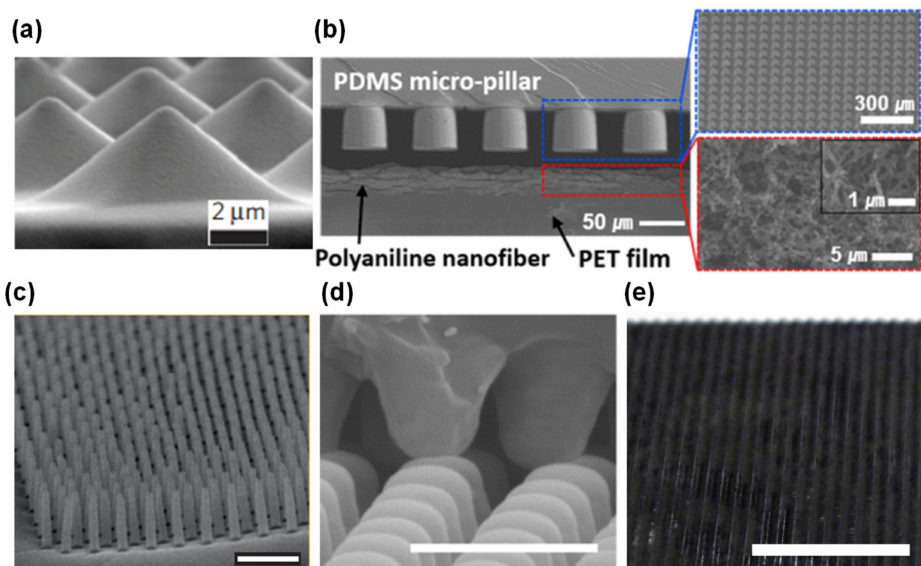
Figure 9. Micro-structures produced through photolithography techniques. ( a ) Pyramids [24] (Copyright © 2020, Springer Nature). ( b ) Pillars (reprinted with permission from [31]. Copyright 2015 American Chemical Society, Washington, WA, USA). ( c ) Hairs [131] (Copyright © 2020, Springer Nature). ( d ) Domes (reprinted with permission from [133]. Copyright 2014 American Chemical